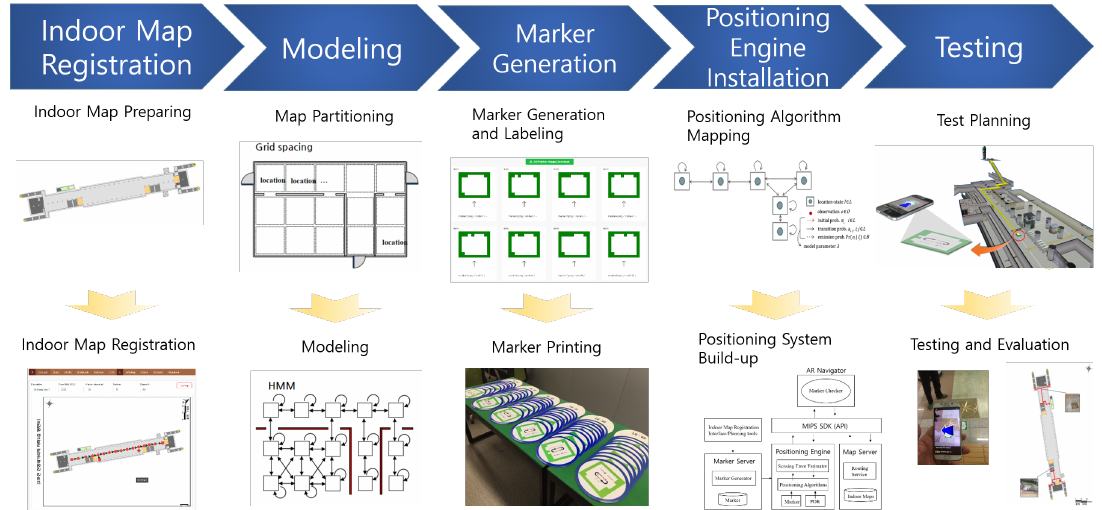
Figure 1. Process of hybrid marker-based indoor positioning